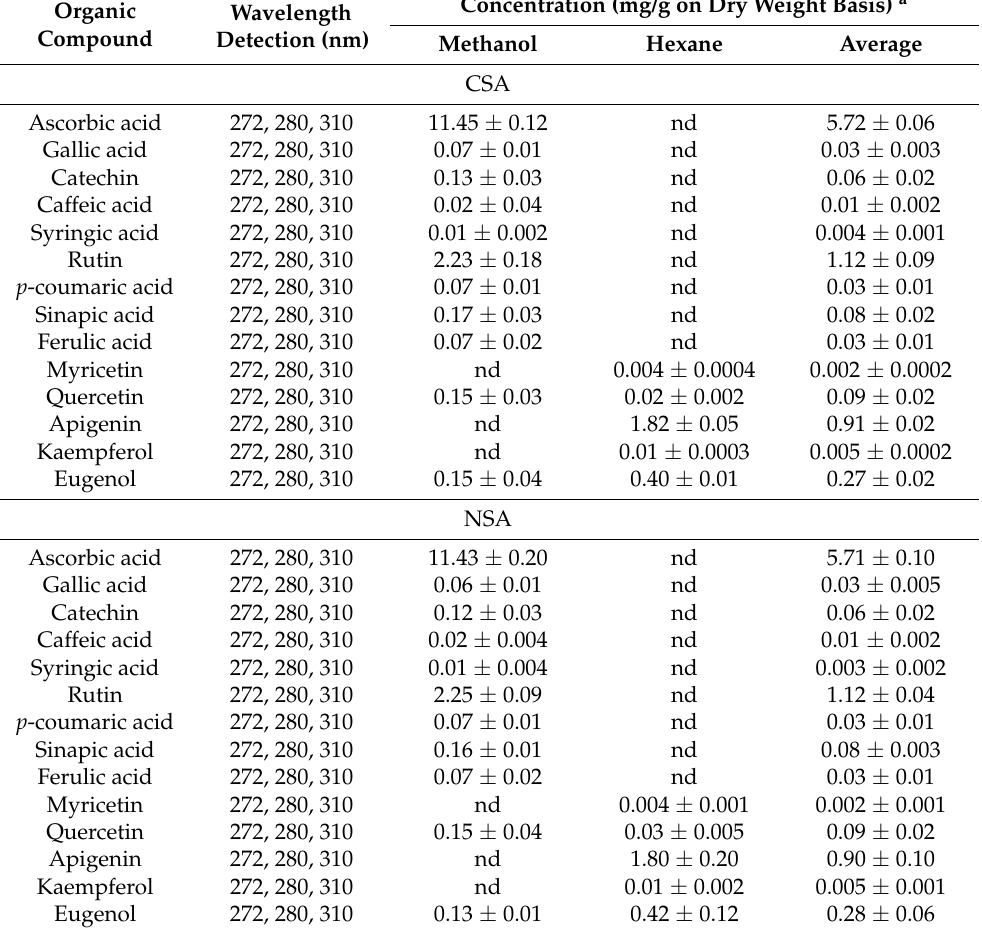
Table 1. Identifying and quantifying selected phytochemicals in methanolic and hexanoic extracts of commercial and noncommercial S. androgynus leaves.